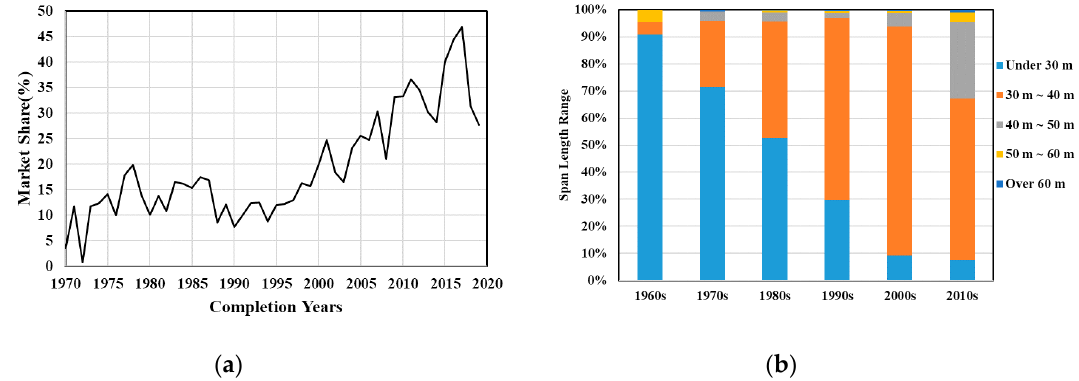
Figure 2. Yearly evolution of prestressed concrete (PSC) I-girder bridge inventory in Korea: ( a ) market share; ( b ) distribution per span length.